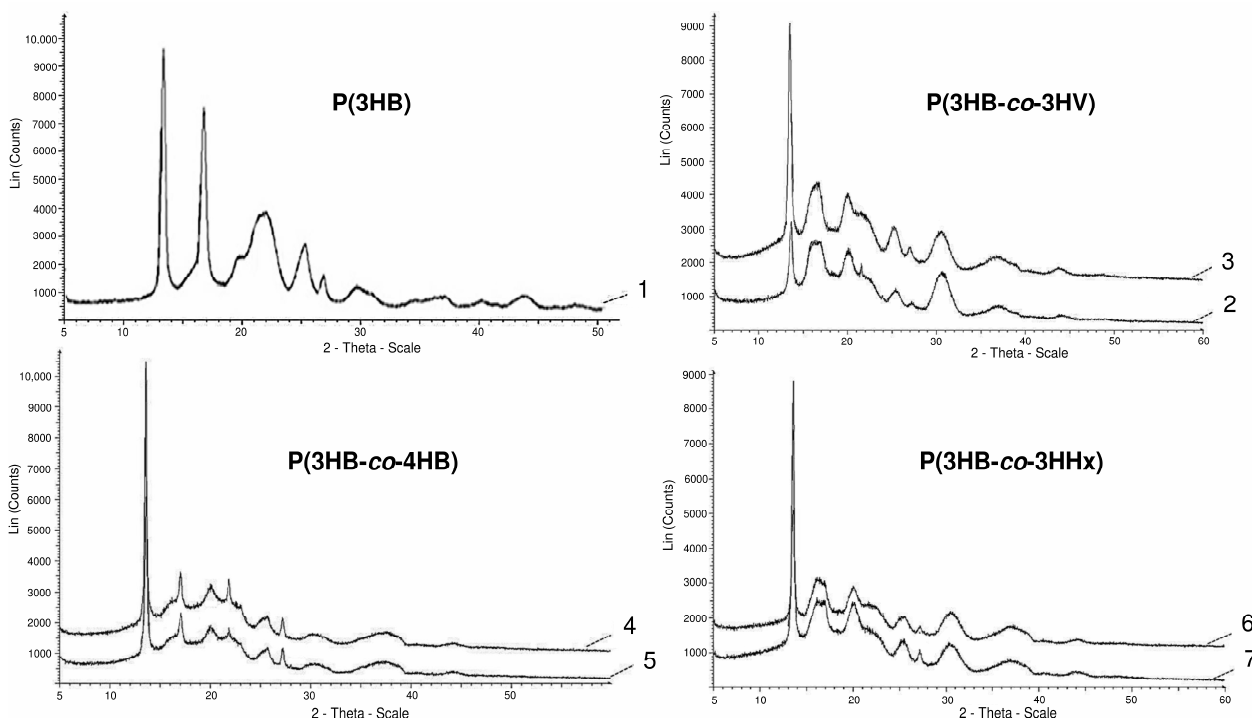
Figure 1. X-ray spectra of PHA samples with different sets of monomers (the numbering indicating the composition of the copolymer is similar to that in Table 1). Table 2. Surface properties of solvent-cast films prepared from PHAs with different